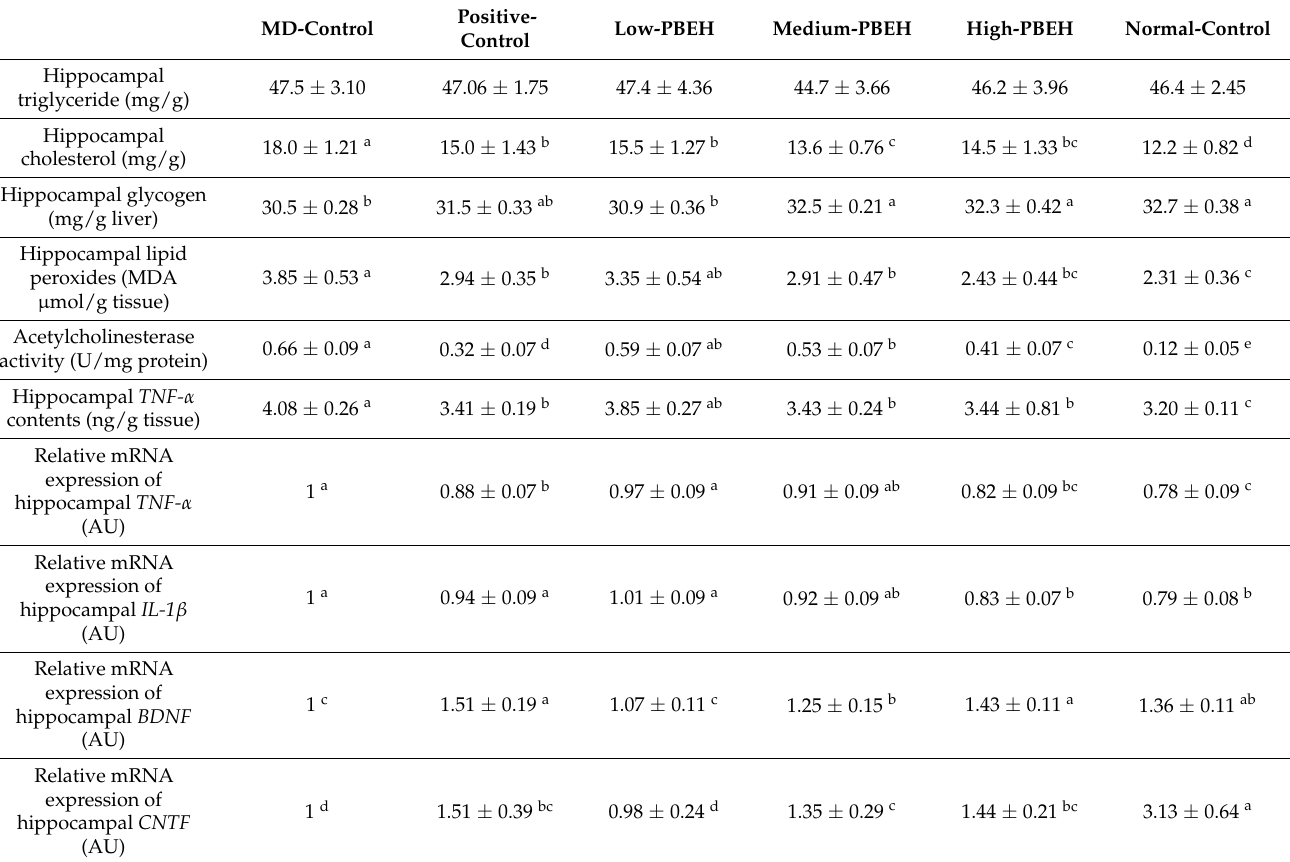
Table 4. Hippocampal lipids, oxidative stress, and neuroinflammation. Positive- MD-Control Low-PBEH Medium-PBEH High-PBEH Control